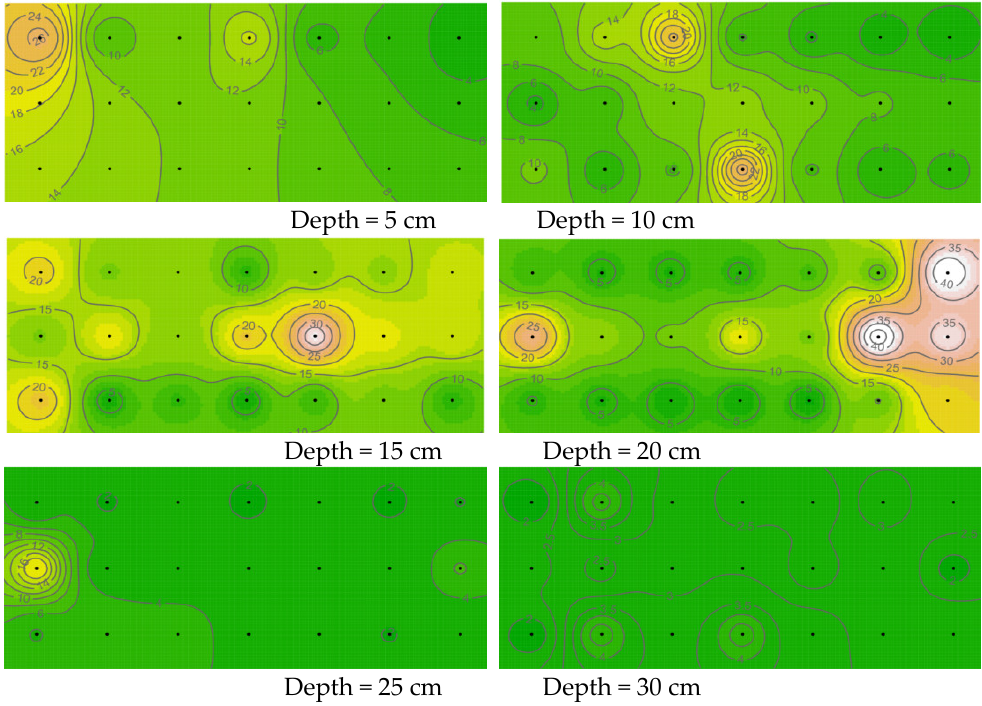
Figure 12. Spatial distribution of calcium carbonate in the different sand layers of the sandy soil.